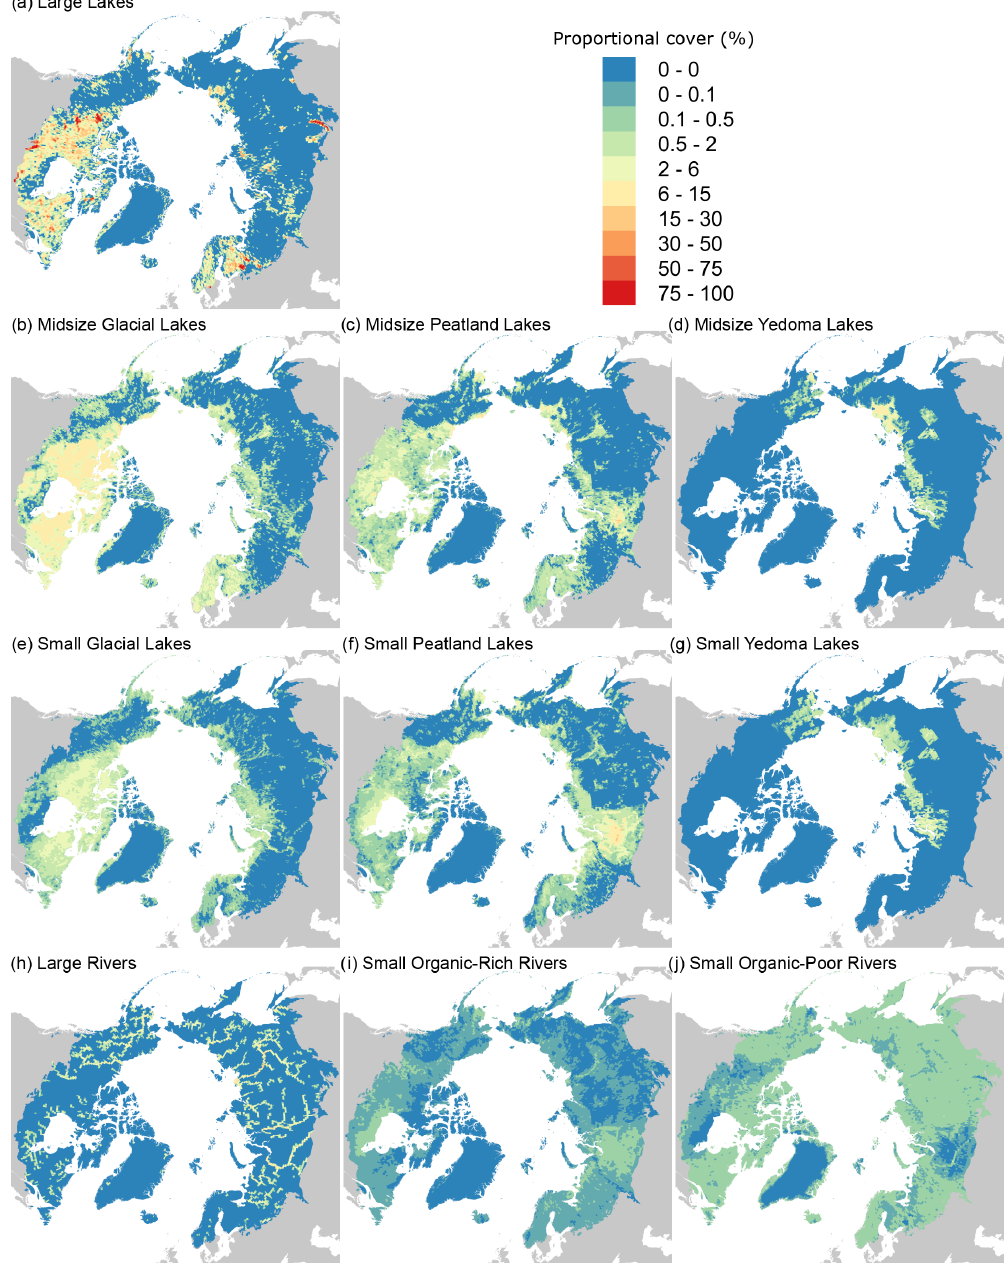
Figure 5. Predicted distributions of lake and river classes within the BAWLD domain: (a) Large Lakes, (b) Midsize Glacial Lakes, (c) Mid- size Peatland Lakes, (d) Midsize Yedoma Lakes, (e) Small Glacial Lakes, (f) Small Peatland Lakes, (g) Small Yedoma Lakes, (h) Large Rivers, (i) Small Organic-Rich Rivers, (j) Small Organic-Poor